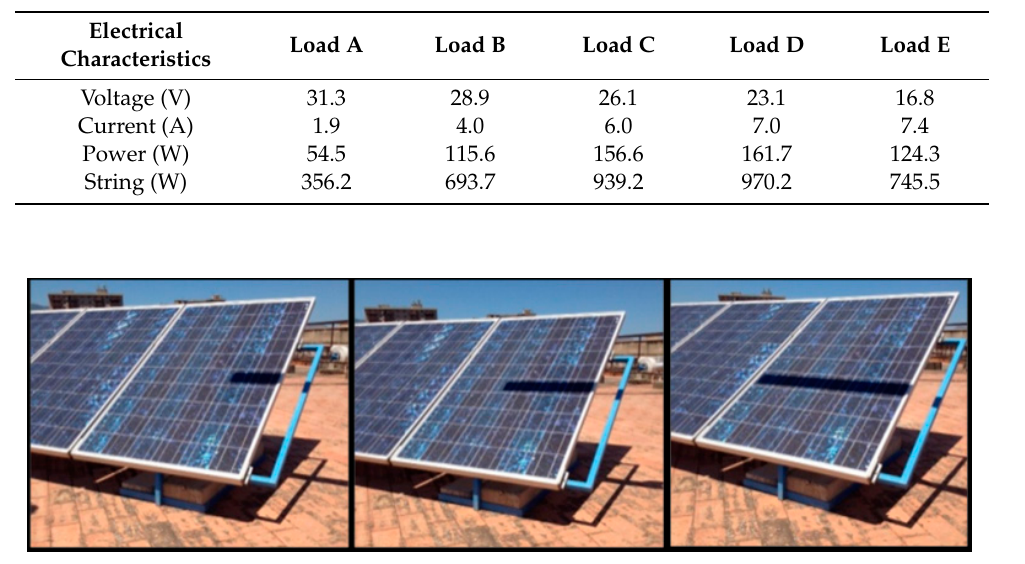
Table 9. Electrical characteristics in di ff erent load conditions evaluated by reconfigurator for each panel.